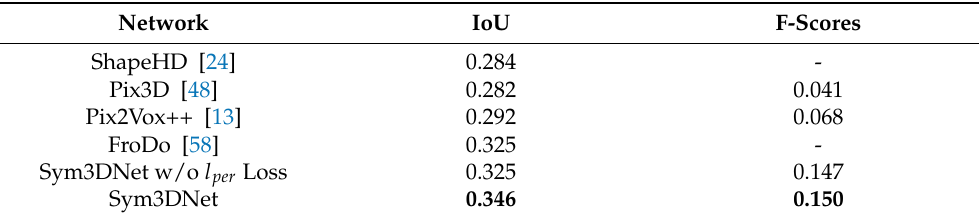
Figure 6. Single view reconstruction on unseen object from ShapeNet datasets. Table 6. Comparison of 3D reconstruction from single-view on a real-world dataset (Pix3D) at 32 × 32 × 32